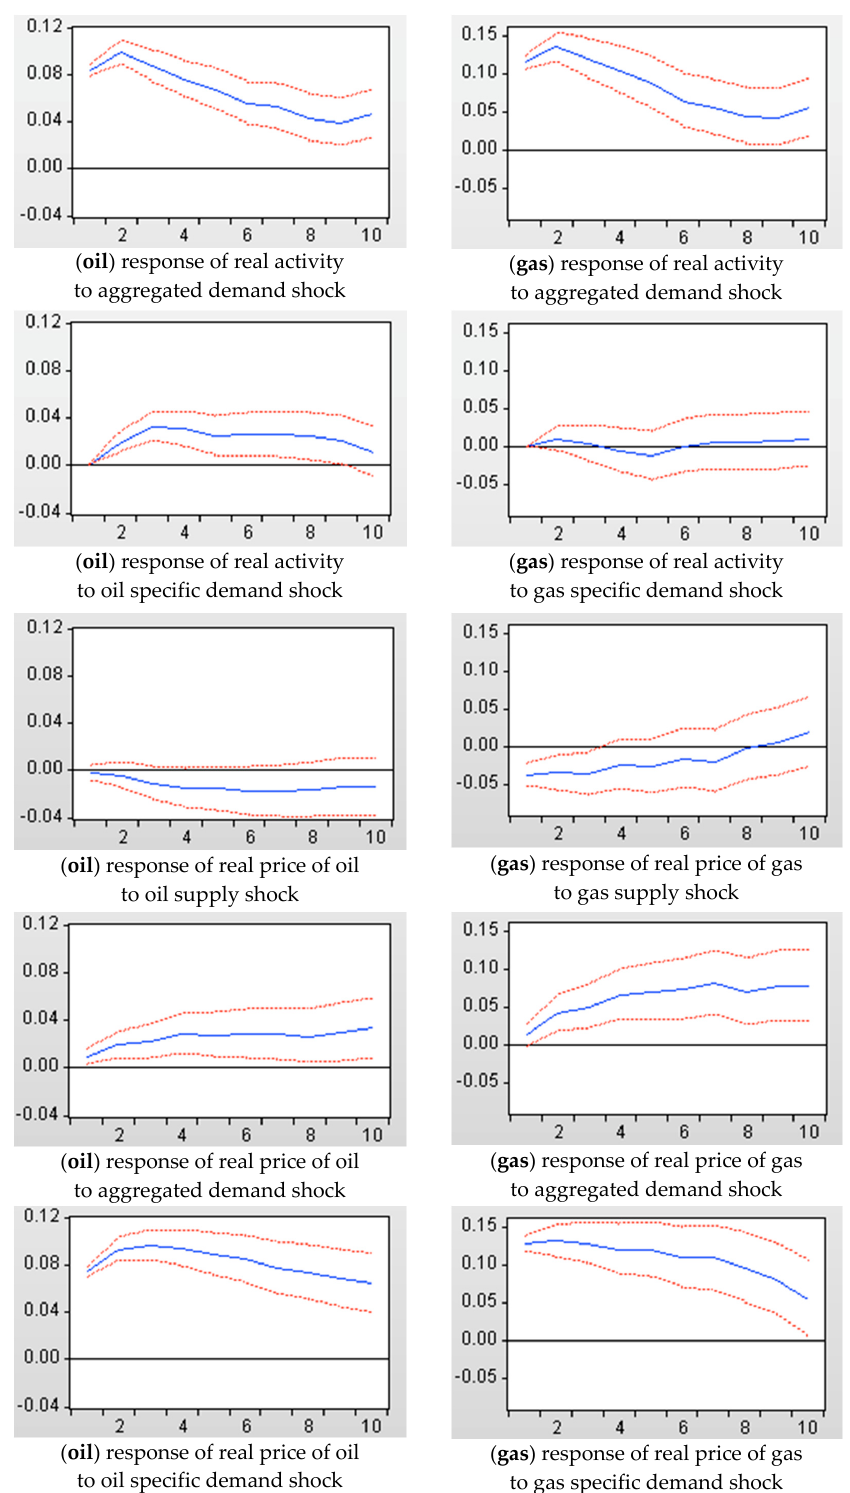
Figure 2. Responses to one-standard-deviation structural shocks. From top to bottom, the first column in ( oil ) illustrates the responses of crude oil production, real economic activity, and the real price of oil, to oil supply shocks, aggregate demand shock, and oil-specific demand shock, respectively. From top to bottom, the second column in ( gas ) illustrates the responses of natural gas production, real economic activity, and real price of gas to gas supply shocks, aggregate demand shock, and gas-specific demand shock, respectively. Note: Estimates based on Equations